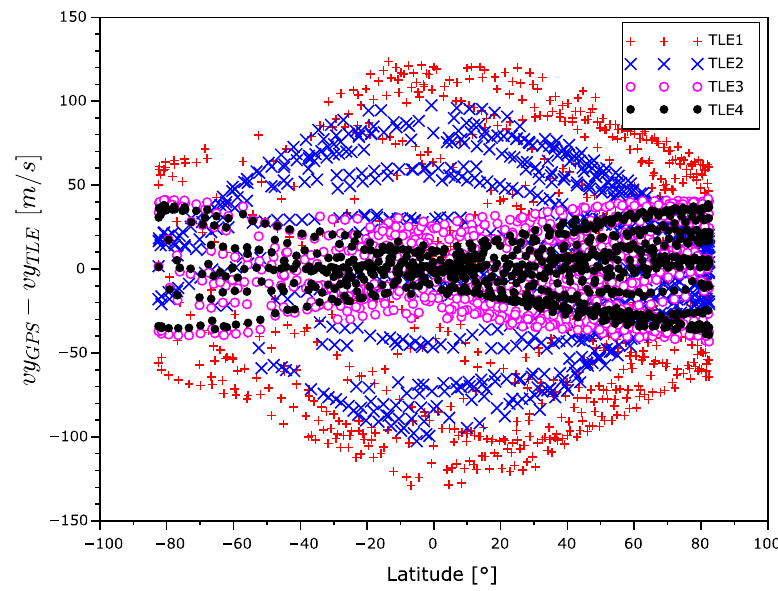
Figure 16. y coordinate velocity error as a function of latitude.